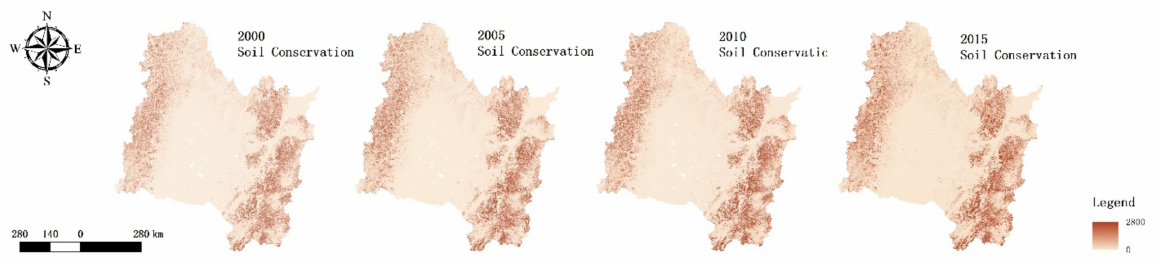
Figure 4. Distribution map of soil